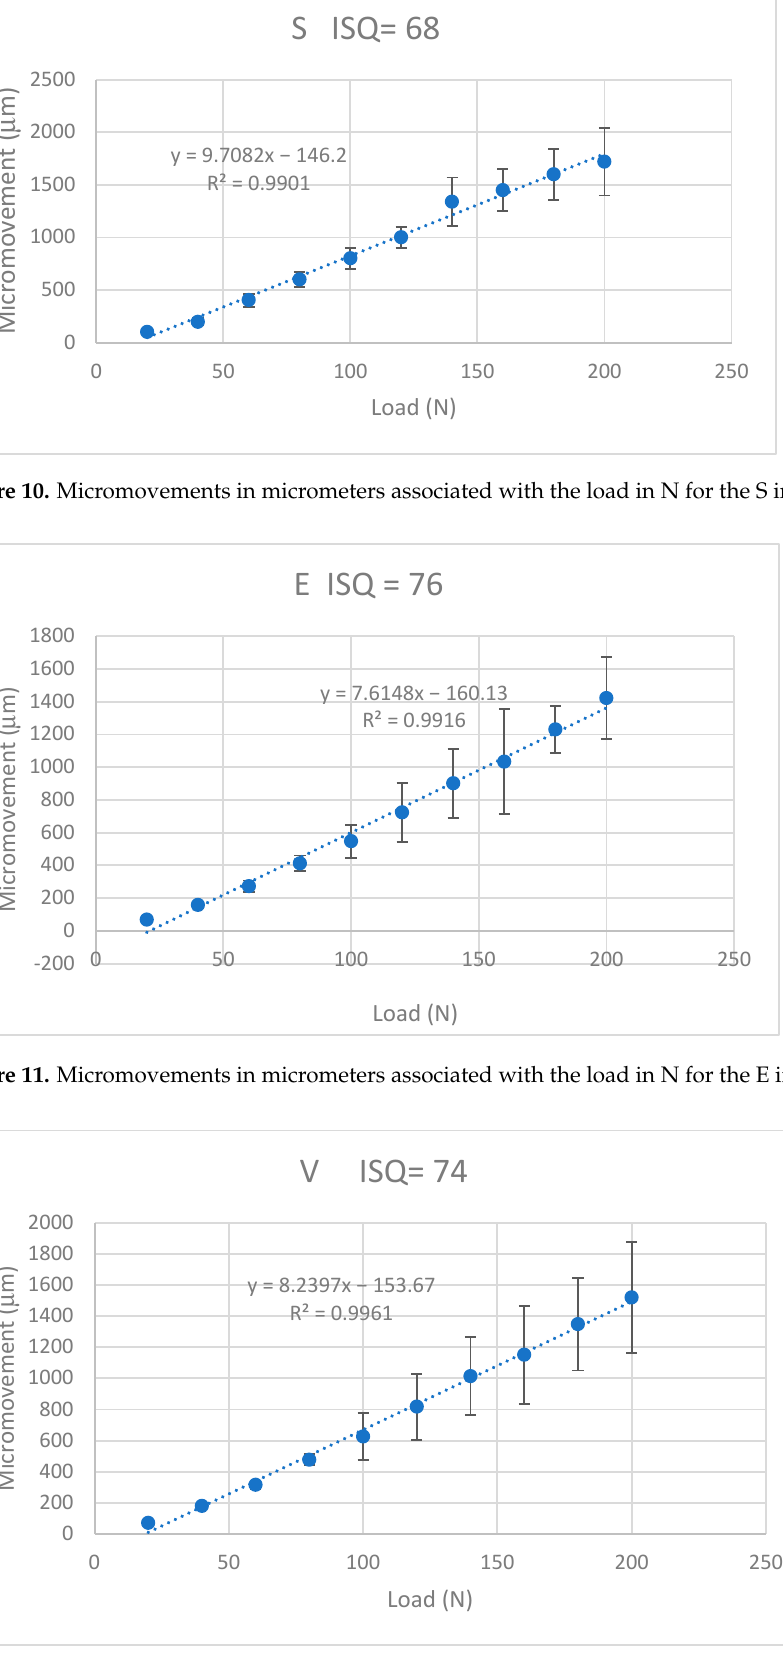
Figure 9. Micromovements in micrometers associated with the load in N for the K implants.